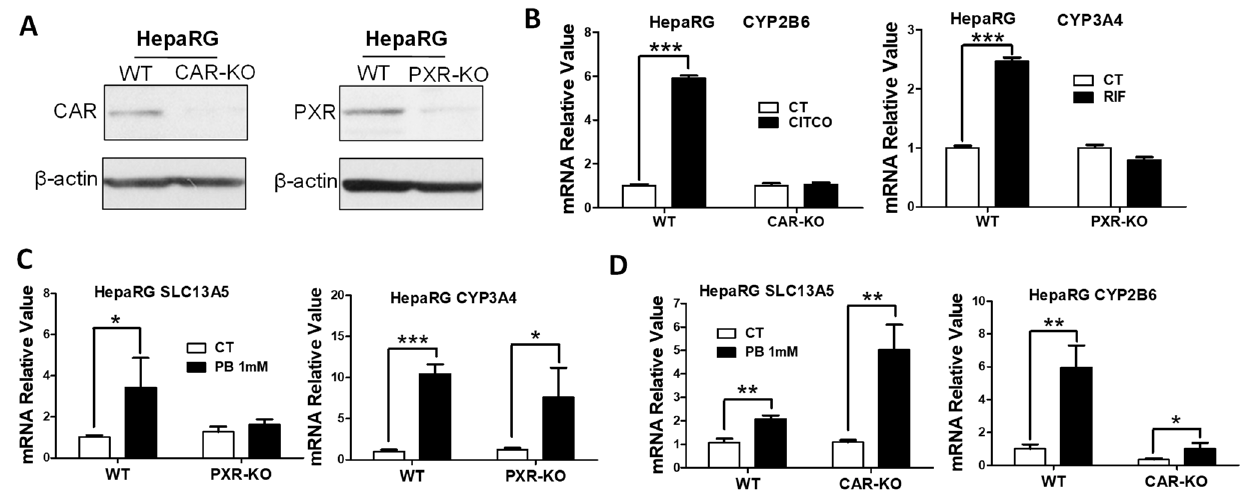
Figure 4. PB induces SLC13A5 expression in HepaRG cells independent of CAR. ( A ) After 21 days of differentiation, cell homogenates prepared from WT, CAR-KO, and PXR-KO HepaRG cells were subjected to western blotting analysis. ( B ) Differentiated WT, CAR-KO, or PXR-KO HepaRG cells were treated with vehicle control (CT), 1 μ M CITCO, or 10 μ M RIF for 24 h before RT-PCR analysis of CYP2B6 and CYP3A4 expression. After 72 h treatment with CT or PB (1 mM), the mRNA expression of SLC13A5 and CYP2B6 ( C ), or SLC13A5 and CYP3A4 ( D ), were measured in differentiated WT-, PXR-KO-, and CAR-KO-HepaRG cells. Data represent the mean ± S.D. ( n = 3), * p < 0.05; ** p < 0.01; *** p < 0.001.